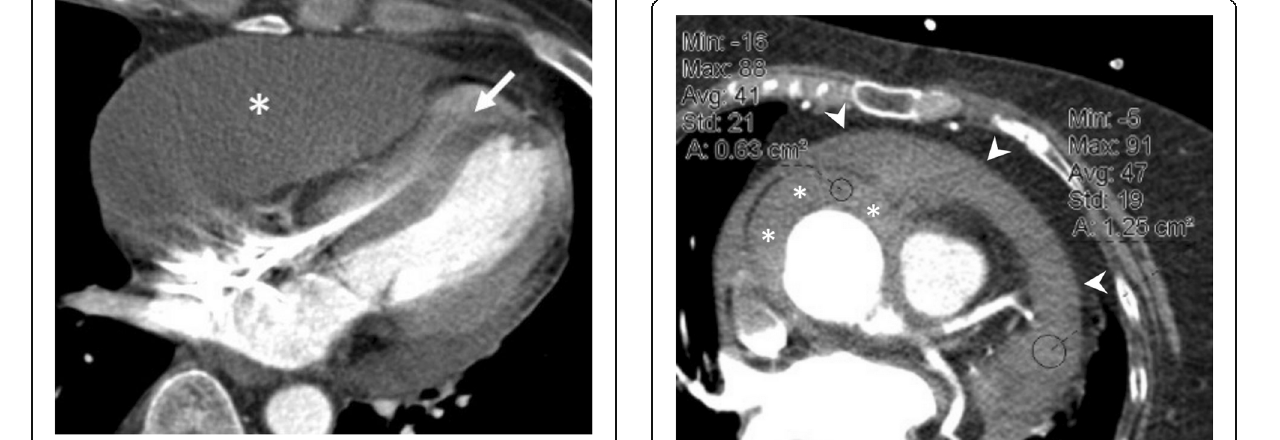
Fig. 5 A 61-year-old man with right heart failure symptoms underwent to CT scan to rule out the presence of pulmonary artery embolism. Axial contrast-enhanced CT image shows significantly compressed right ventricle (arrow) due to the loculated pericardial effusion (asterisk)